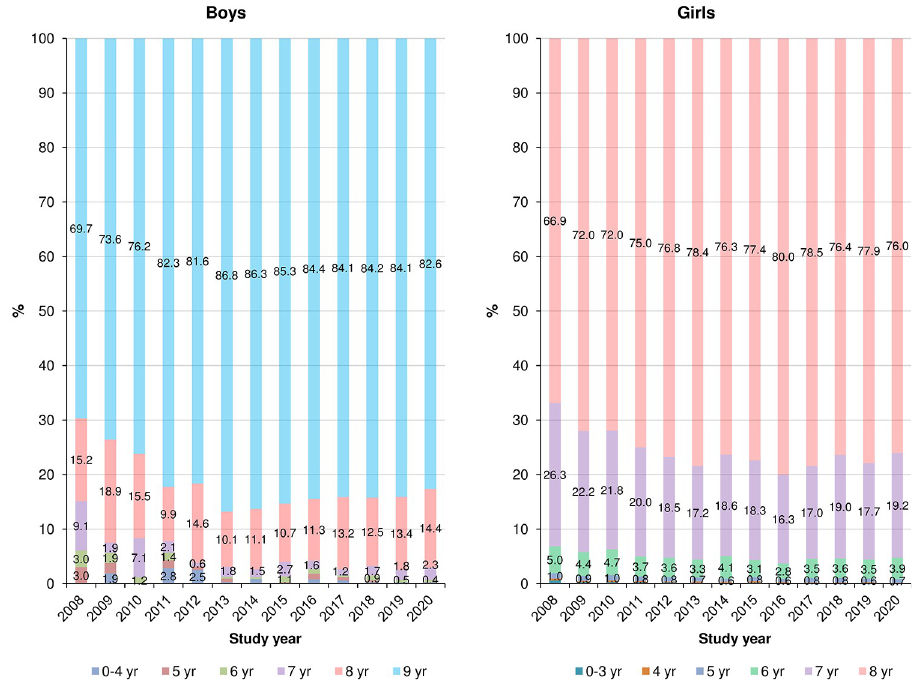
Fig 3. Age distribution of central precocious puberty patients according to sex and calendar